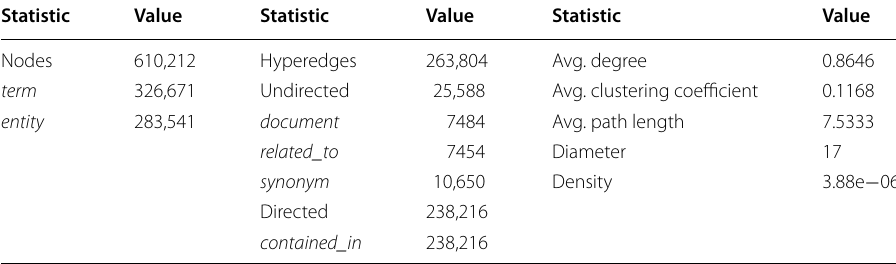
Table 3 Global statistics for the synonyms model